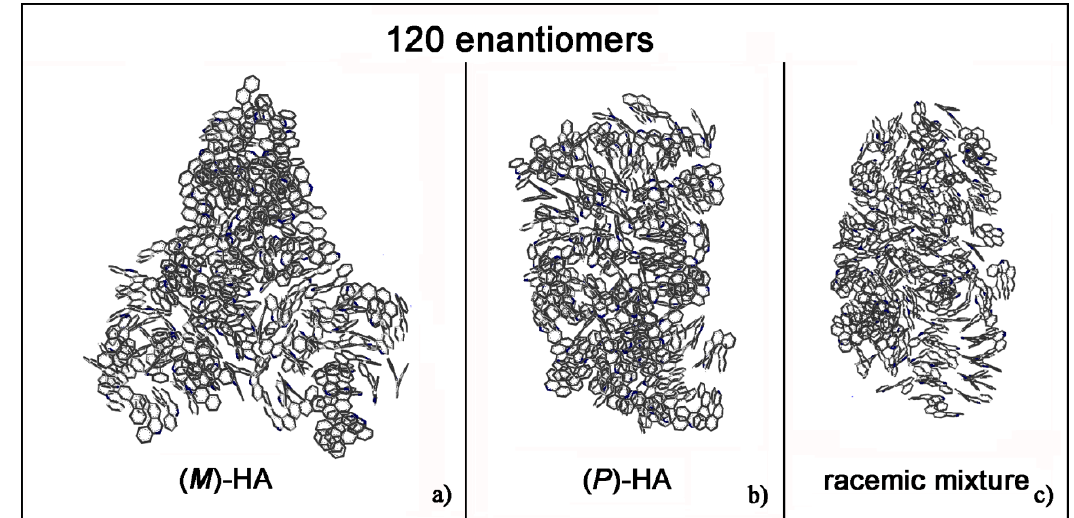
Figure 2. Optimized geometries at the end of MD run lasting 20 ns considering 120 ( M )-HA ( a ), 120 ( P )-HA ( b ) and the racemic mixture of 120 enantiomers ( c ). All atoms are in grey and the hydrogens are omitted for clarity.